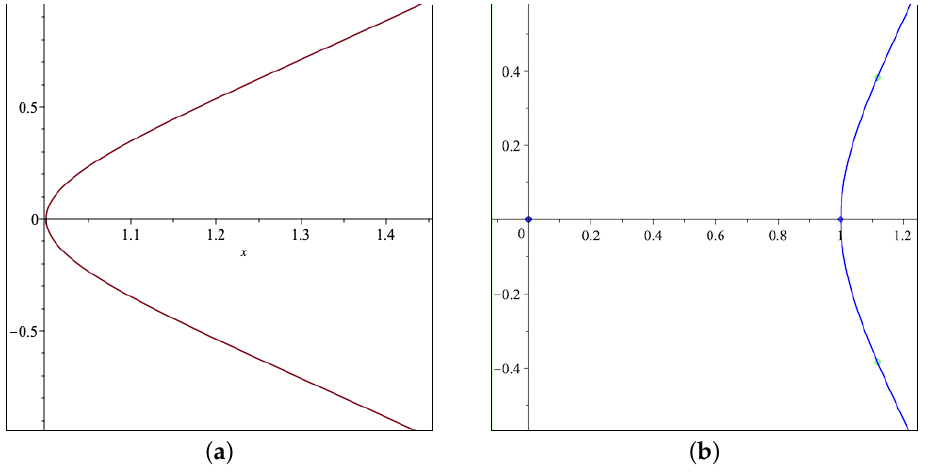
Figure 7. Graphic output of Maple for the curve x 2 + y 2 − x 3 = 0 ( a ) with the implicitplot() command; ( b ) with the plot_real_curve()